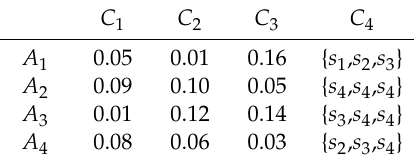
Table 5. Normalized law enforcement possibility evaluation matrix of judgment debtors.